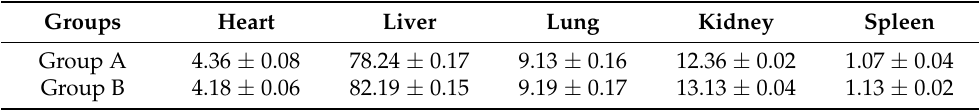
Table 9. Different organ weight (g) of rabbits in Group A and Group B.